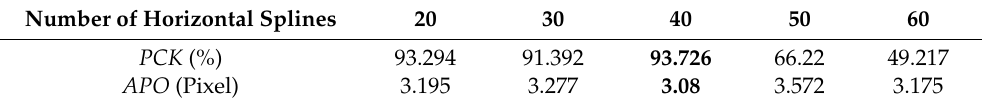
Table 2. Comparisons of Model Performance Using Different Horizontal Splines. Number of Horizontal